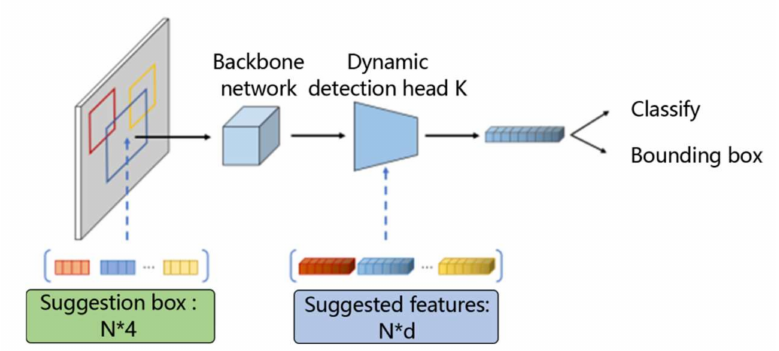
Figure 1. Schematic diagram of a Sparse R-CNN